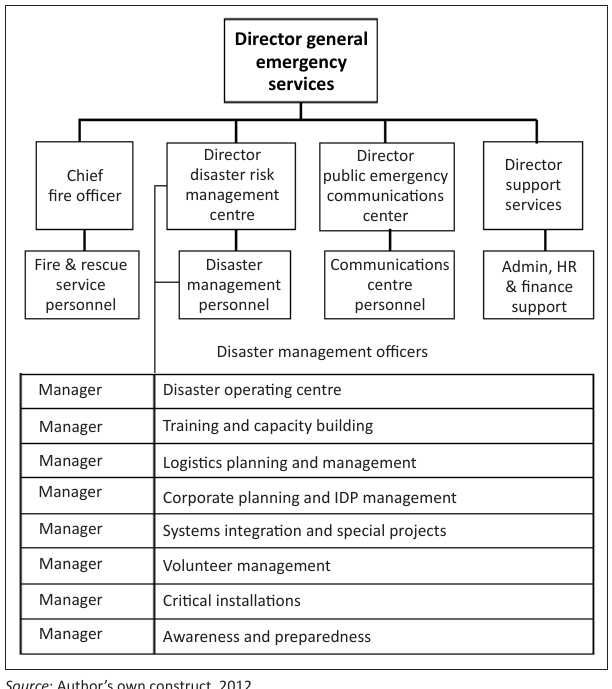
FIGURE 3: Proposed Emergency Services